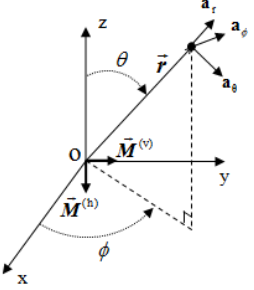
Figure 10. The coordinate system for electric fields from a pair of h microstrip radiating elements. M is the magnetic current density v of a horizontally polarized radiating element. M is the magnetic current density of a vertically polarized radiating element hydrome- teors are located at range r . Unit vectors a r , a θ , and a ϕ form a local orthogonal system at r (Lei et al.,